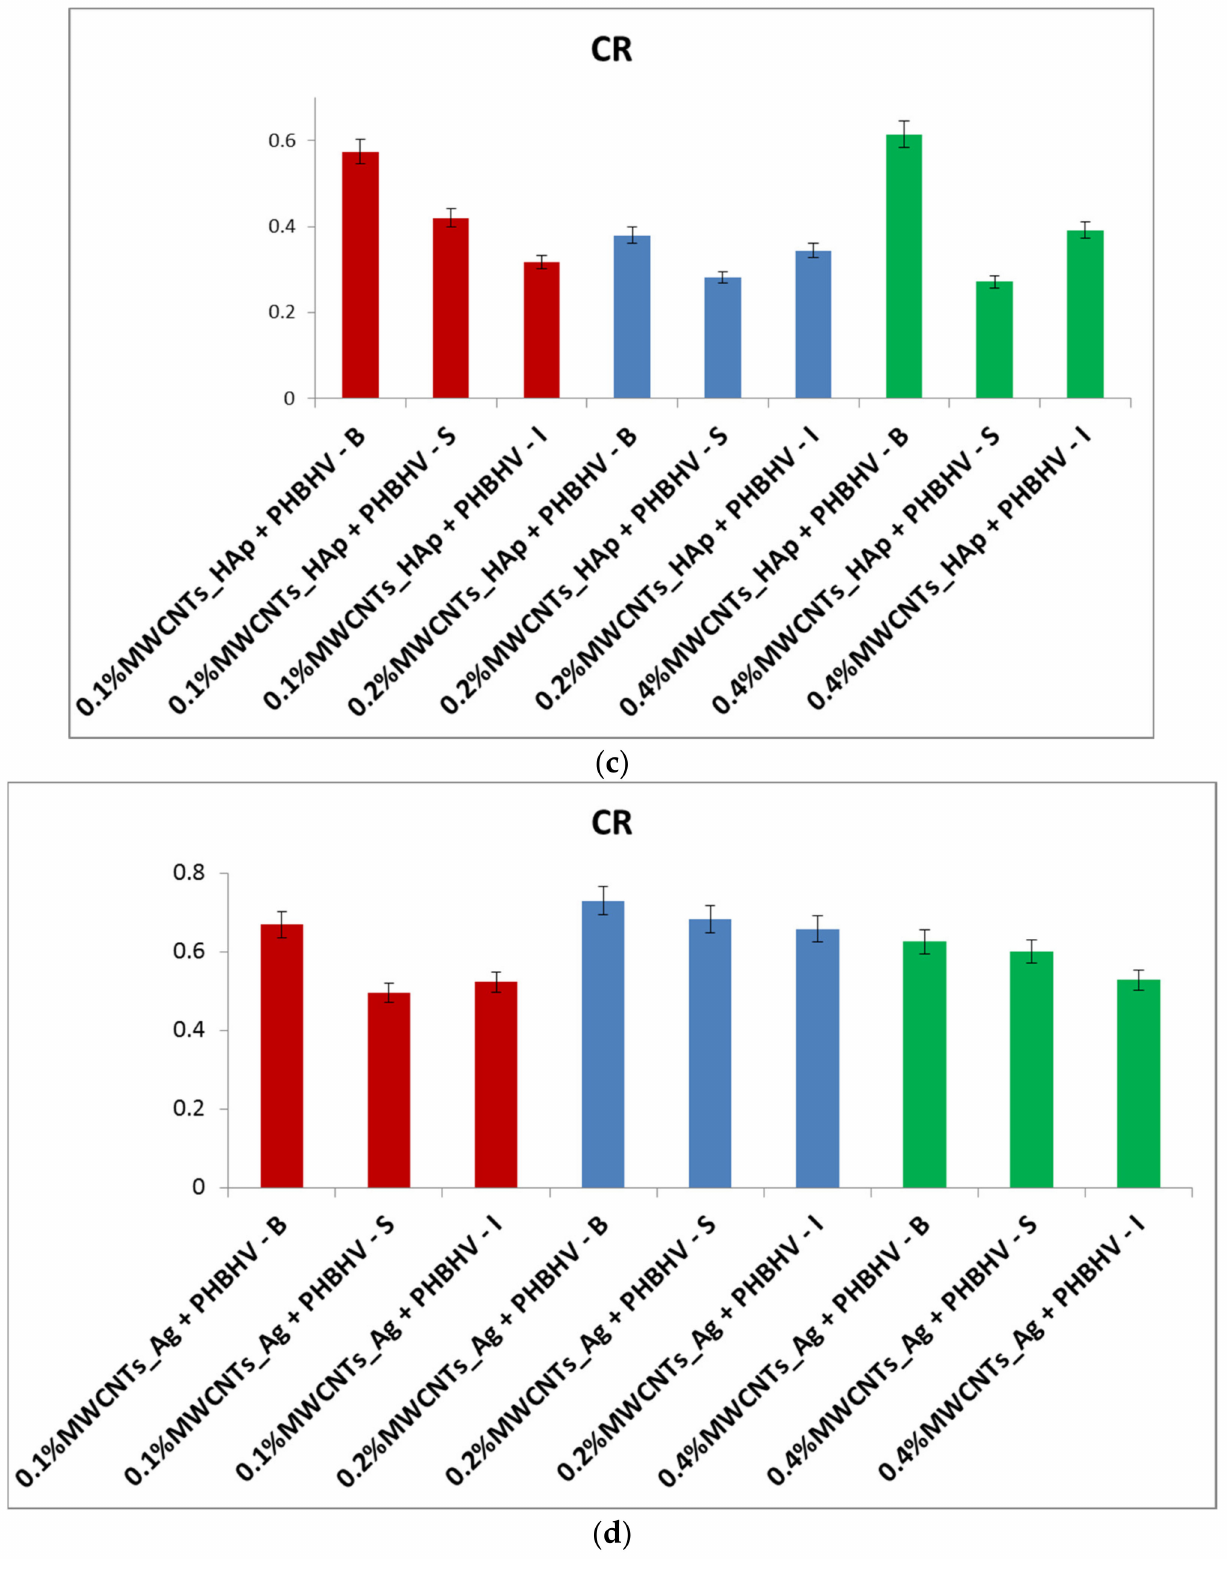
Figure 1. CR calculated for the treated samples: ( a ) MWCNTs + PHBHV set, ( b ) MWC- NTs_ZnO + PHBHV set, ( c ) MWCNTs_HAp + PHBHV set and ( d ) MWCNTs_Ag + PHBHV set. The results are presented as the mean ± S.D. of three